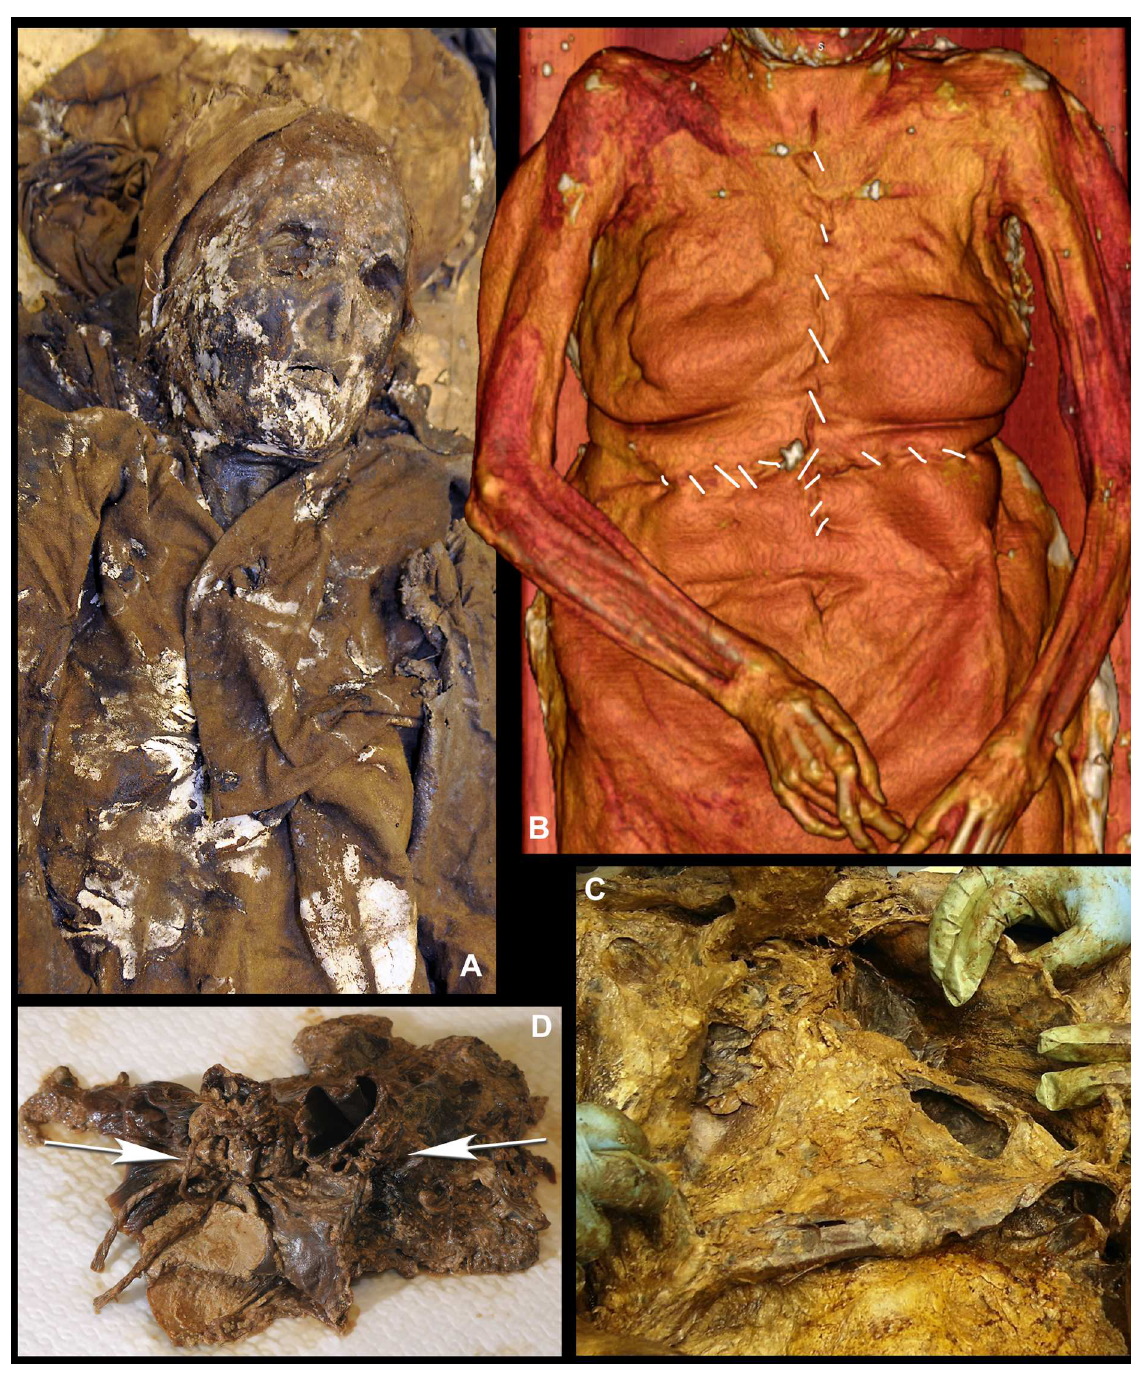
Fig 8. The Post mortem Surgical Operation on Louise de Quengo’s Body. (A) View of the top half of Louise de Quengo’s body, partially unclothed.(B) The thorax was cut into with two large incisionsin the shape of a cross: one extendingfrom the suprasternal notch to just above the navel, the other, perpendicular to the first, beneaththe chest, in front of the lower ribs. The integumentswere partially folded over to allowaccess to the sterno-costal cartilage(2 to 12), which was then severedwith clean, bilateralcuts. The breastplatewas lifted, givingaccess to the organs and allowingthe diaphragmcupolato be severed(C). A vertical cut, 5 cm long, was made on the left side of the pericardialsac (D). Inside the pericardialcavity, the aorta and the pulmonary artery, whose supravalvular portionsremainedintact, were ligatedshut with two separate ties using thread similar to that used to close the incision in the thorax. The principalblood vessels were severed and the pericardialsac emptiedof its contents. The breastplate was repositioned,the soft tissues put back in, and the abdominal-thoracic incision crudelysewn closed.